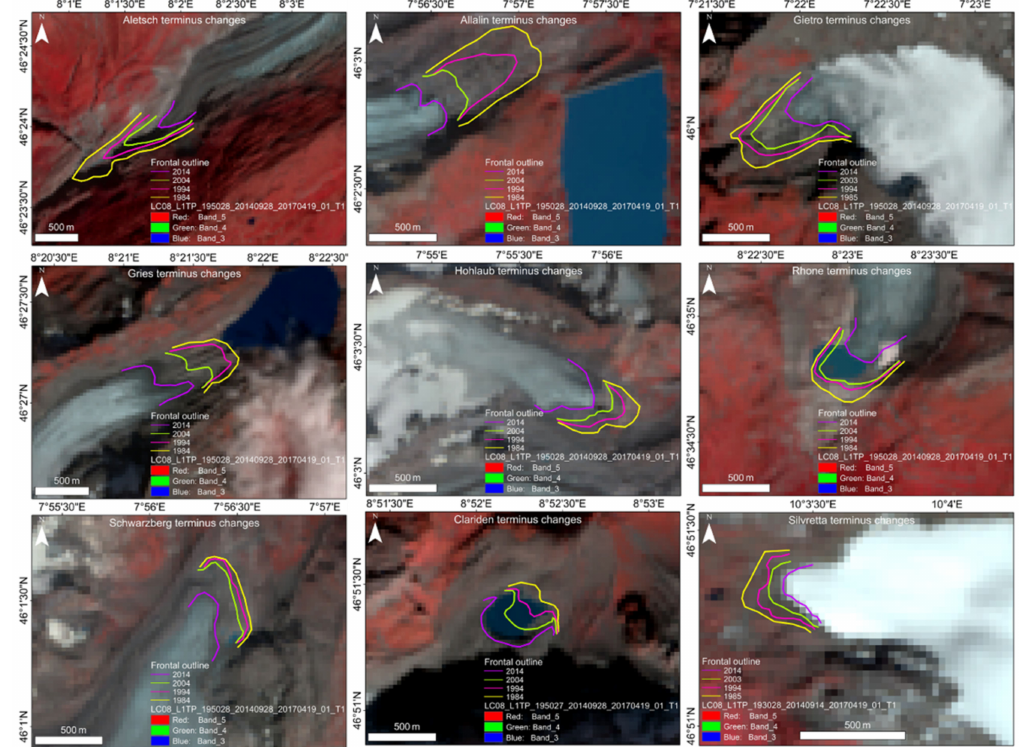
Figure 10. Glacier terminus changes during